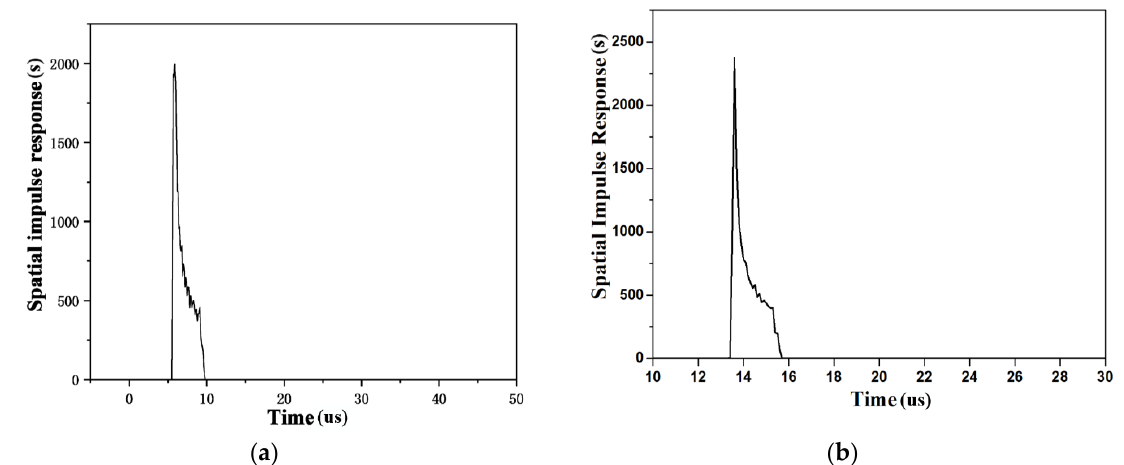
Figure 17. Spatial impulse response on acoustic axis: ( a ) Z = 8 mm; ( b ) Z = 20 mm.